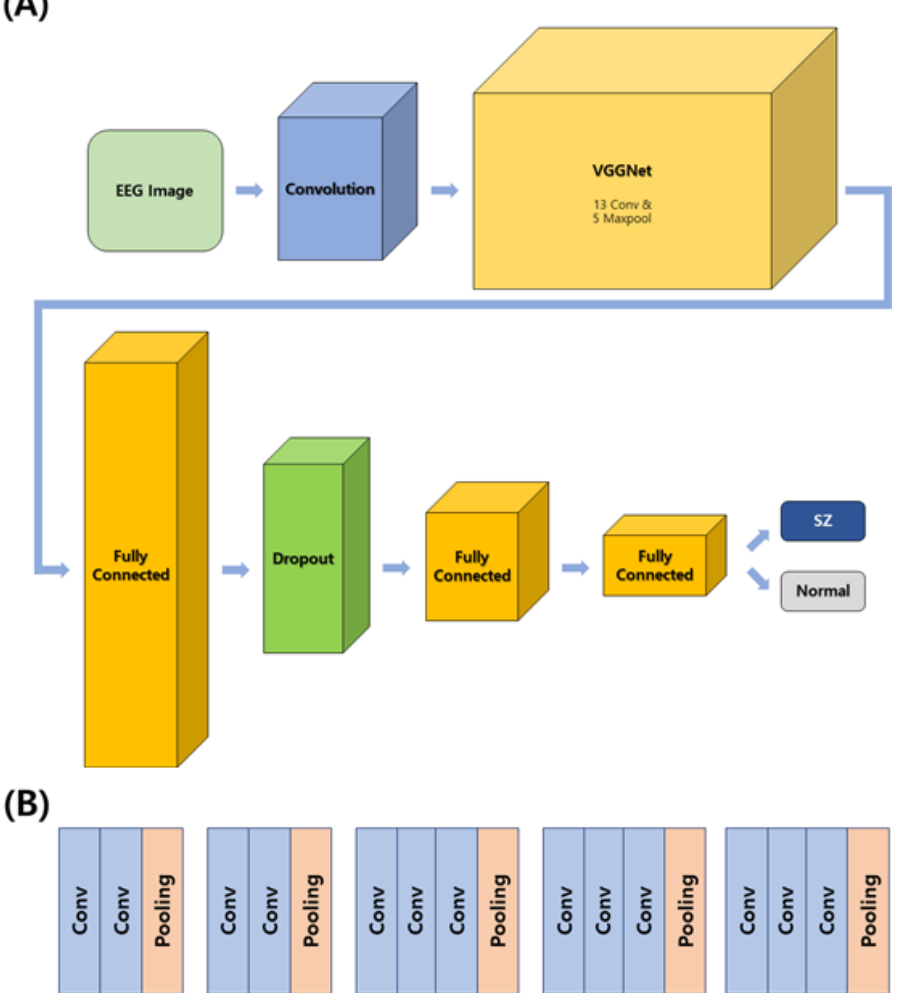
Figure 3. VGGNet-based deep learning model ( A ) and VGGNet ( B ) for schizophrenia EEG image